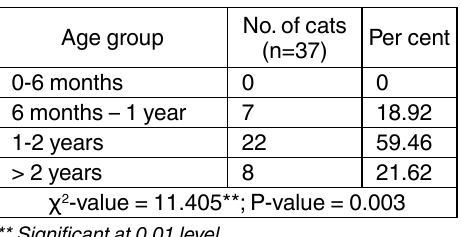
table 2 . Age-wise occurrence of FLUTD in